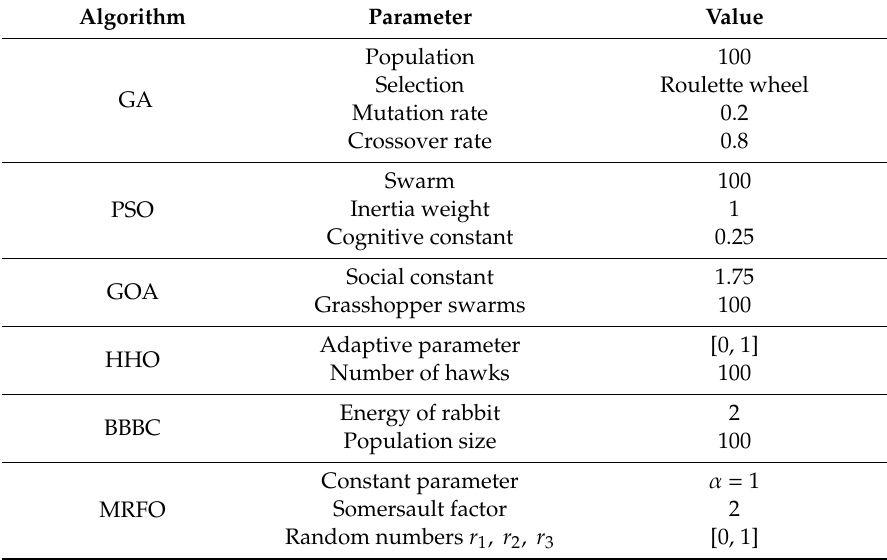
Table 3. Main parameters of the six computational intelligence-based algorithms. Algorithm Parameter Value Population 100 Selection Roulette wheel GA Mutation rate 0.2 Crossover rate 0.8 Swarm Inertia PSO